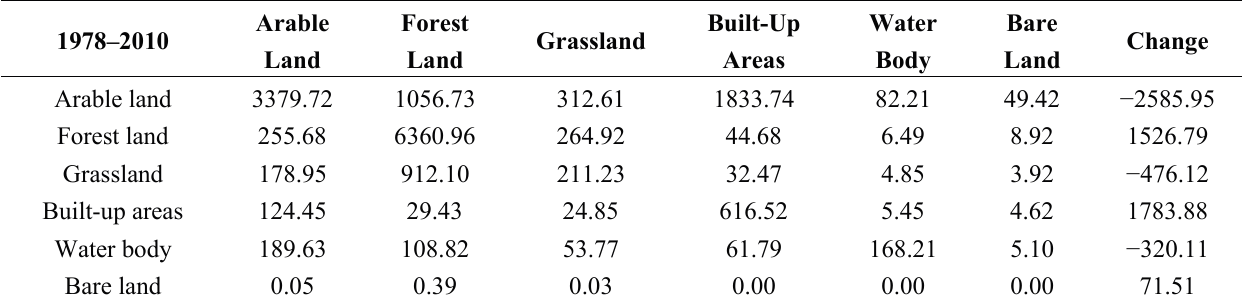
Table 6. Transition matrix of LULC in Beijing, China, from 1978 to 2010 (km 2